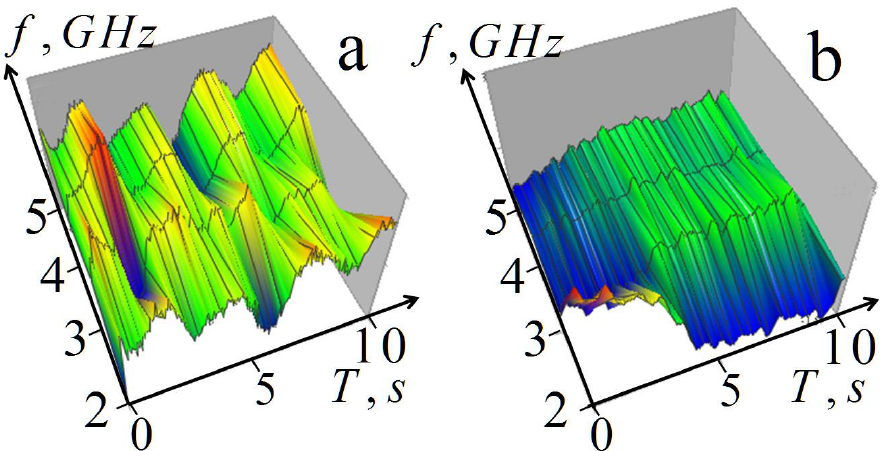
Figure 10. Four-frequency measurements of scattered signal amplitude variations during breathing: ( a ) free breathing; ( b ) exhalation followed by breath-holding. ( a ) free breathing; ( b ) exhalation followed by